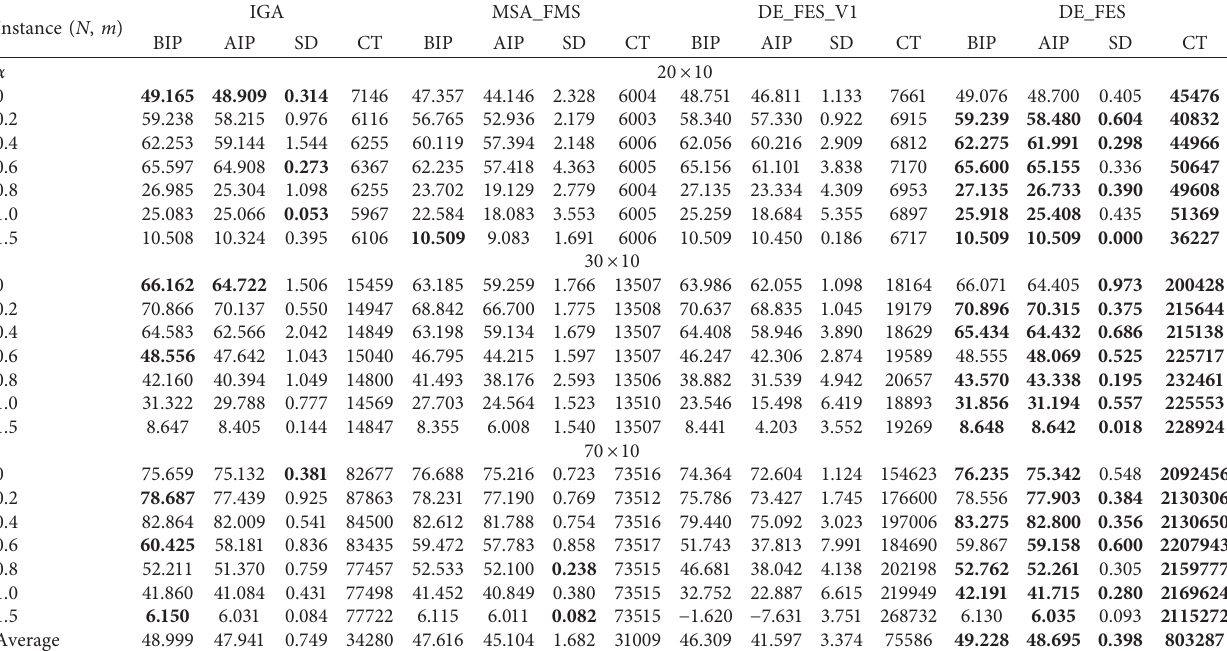
Table 2: Comparison results of four algorithms on 21 instances with different α